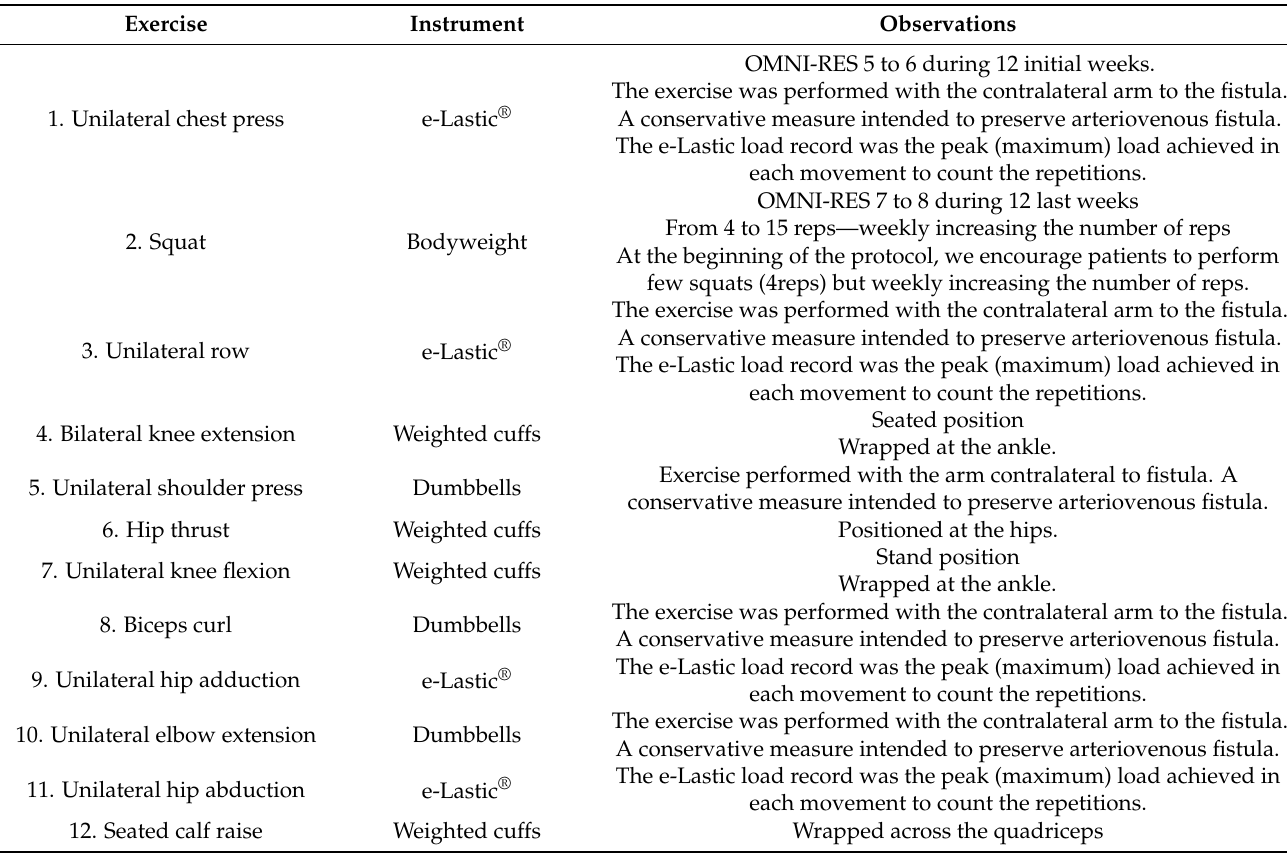
Table 1. Training